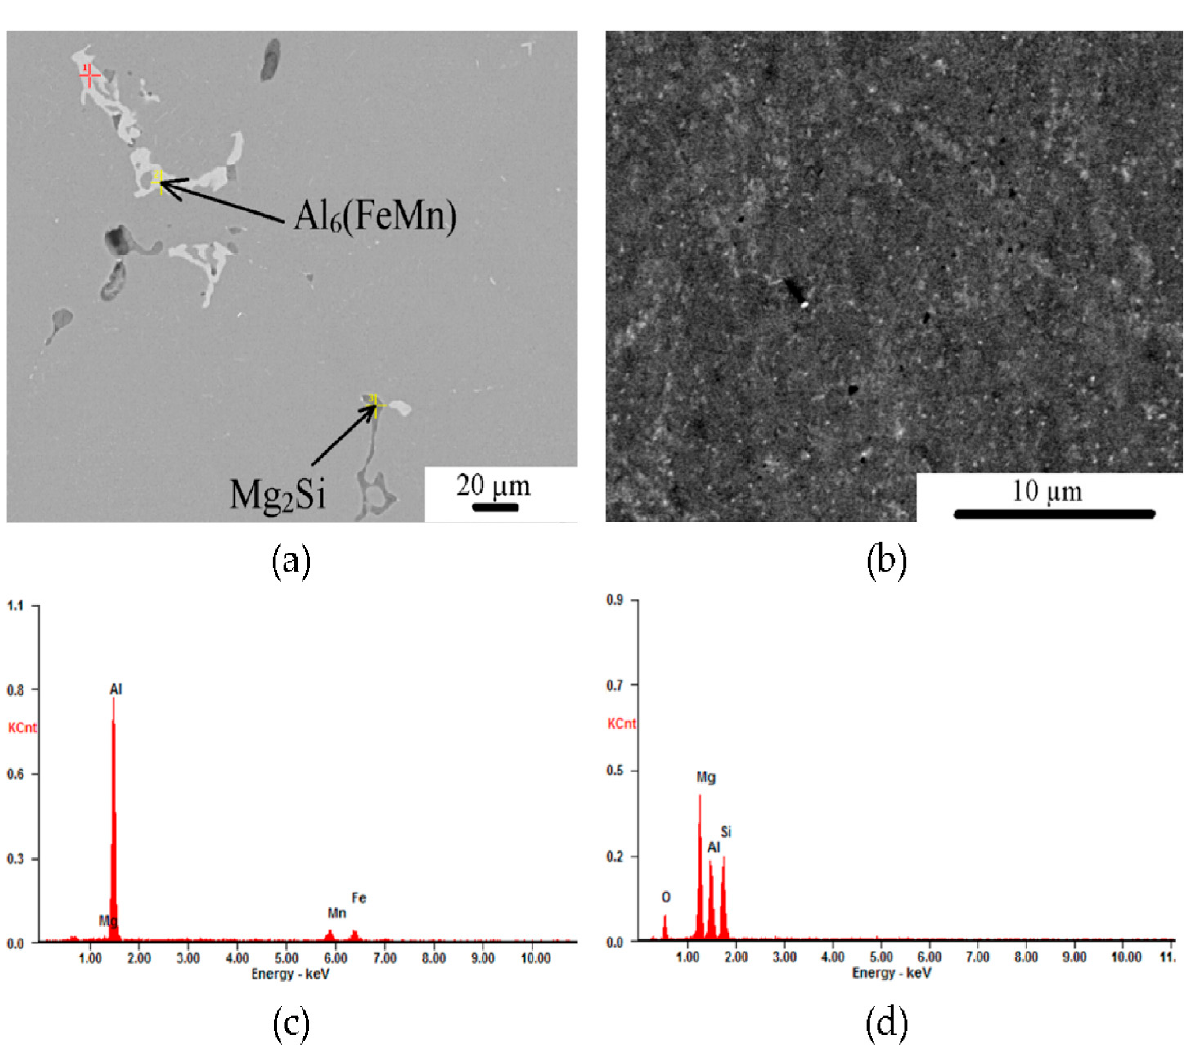
Figure 3. Second phase particles in the as-cast state of the 1565 ch alloy: ( a ) large 10.3 µm intermetallic compounds; ( b ) small 0.32 µm primary intermetallics; ( c ) EDS for Al 6 (FeMn) particles; ( d ) EDS for Mg 2 Siparticles.